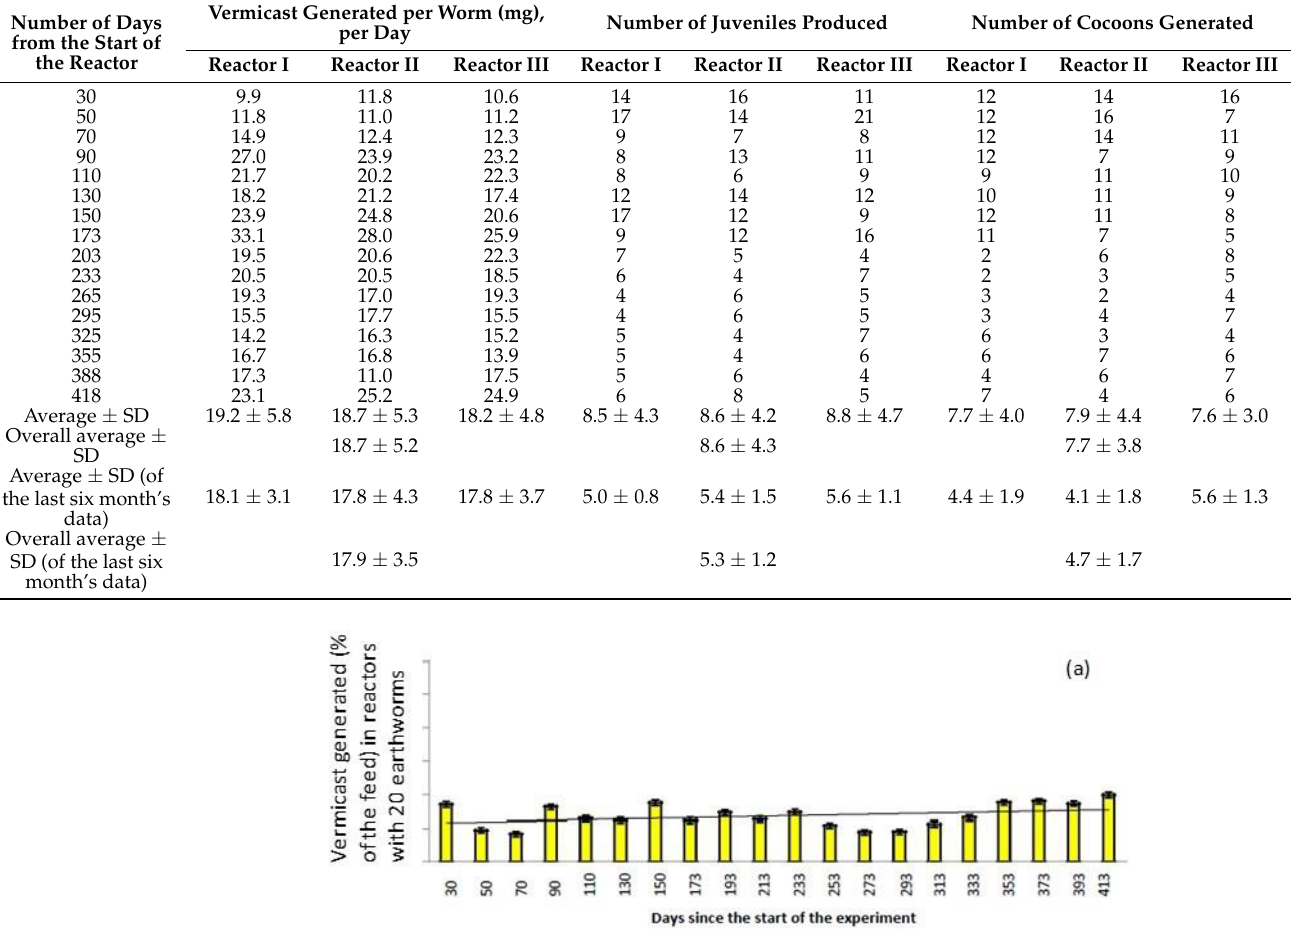
Table 12. Vermicomposting of ipomoea with 80 adults of E. fetida per kg of feed in pulse-fed modules.